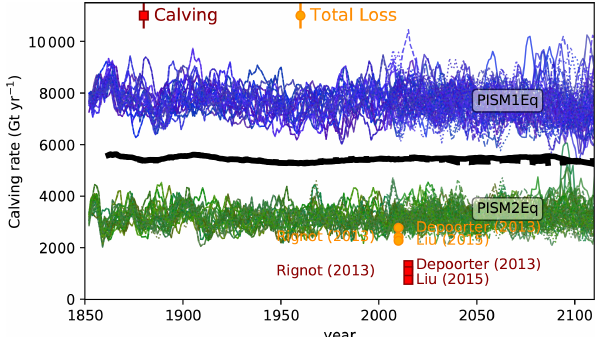
Figure E12. Temporal evolution of Antarctic-wide calving rates for the period from 1850 to 2100. All simulations start under historical conditions and continue after 2005 under the RCP8.5 (solid lines), RCP4.5 (dashed lines), or RCP2.6 (dotted lines) scenarios. After the year 2100, the forcing of the last 30 years until 2100 drives the model recurrently. The thin blue lines are all ensemble members starting from the PISM1Eq initial state, where the Eigen-calving parameter amounts 10 18 ; the green lines are the corresponding simulations starting from PISM2Eq (Eigen-calving parameter 10 17 ). A running mean with a 5-year window has been applied for the thin lines. The thick black lines represent the ensemble mean of the three future scenarios with a 25-year moving window. The applied running means shift the apparent maximum backward in time so that it occurs visually before the year 2100. Recent estimates of the total (orange circles) and the calving (red squares) ice mass loss are given for three studies (legend at the top). Vertical bars depict the reported uncertainties of the estimates from Liu et al. (2015), Depoorter et al. (2013), and Rignot et al.